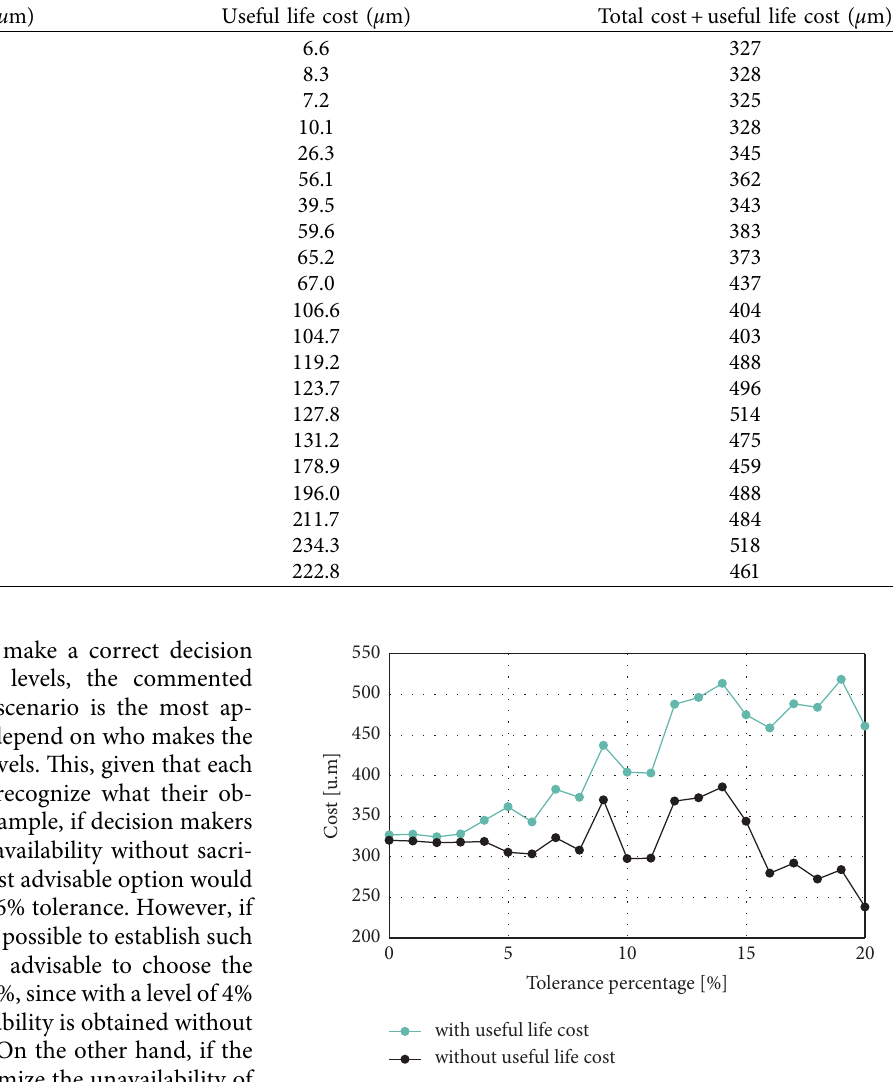
Figure 11: Evolution of total and lifetime costs with respect to each permitted tolerance